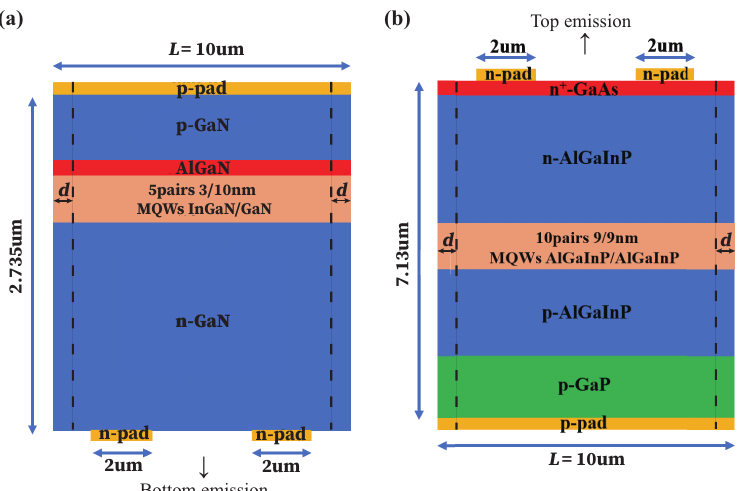
Figure 1. Structures of the 10- µ m ( a ) blue and ( b ) red [11] LEDs, showing two 2- µ m n-pads and one 10- µ m p-pad. The depletion region (denoted by “d”) near the QW is approximately 100 nm